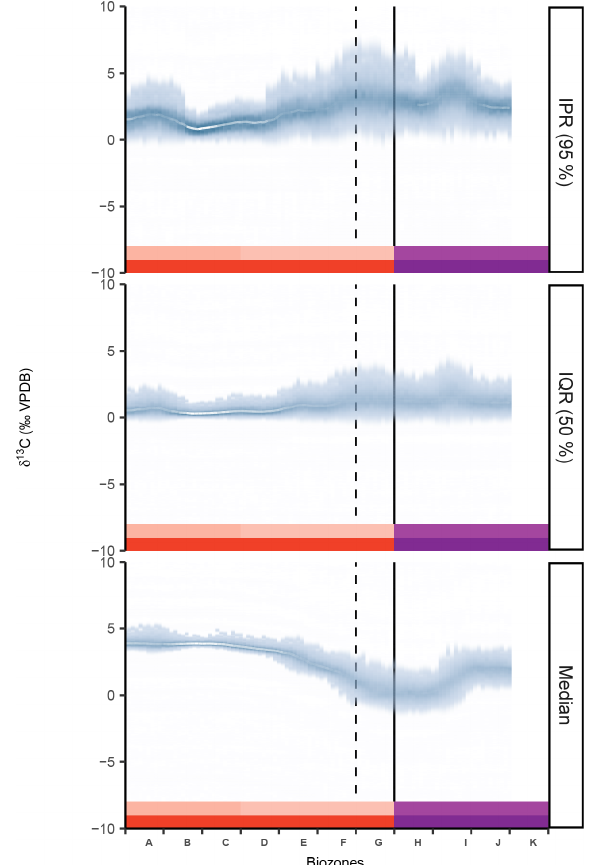
Figure 8. Subsampled virtual carbon isotope time series with model results plotted as “visually weighted” trends. Each time unit incor- porates 50 model iterations with a randomly chosen OC flux from a log-normal skewed density distribution. The time series simulates an increase of 4 times the average OC flux, a 1.5 times increase in the spatial heterogeneity of OC accumulation and increased likeli- hood of producing sea-floor authigenic carbonate to a maximum of 1 in 10. Bioturbation (expressed as bio-mixing and bio-irrigation) is modulated at the extinction horizon to mimic the effect of a die- off among benthic organisms. In addition, sedimentation ( v and w ) is increased twofold over the P–Tr transition (see main text for